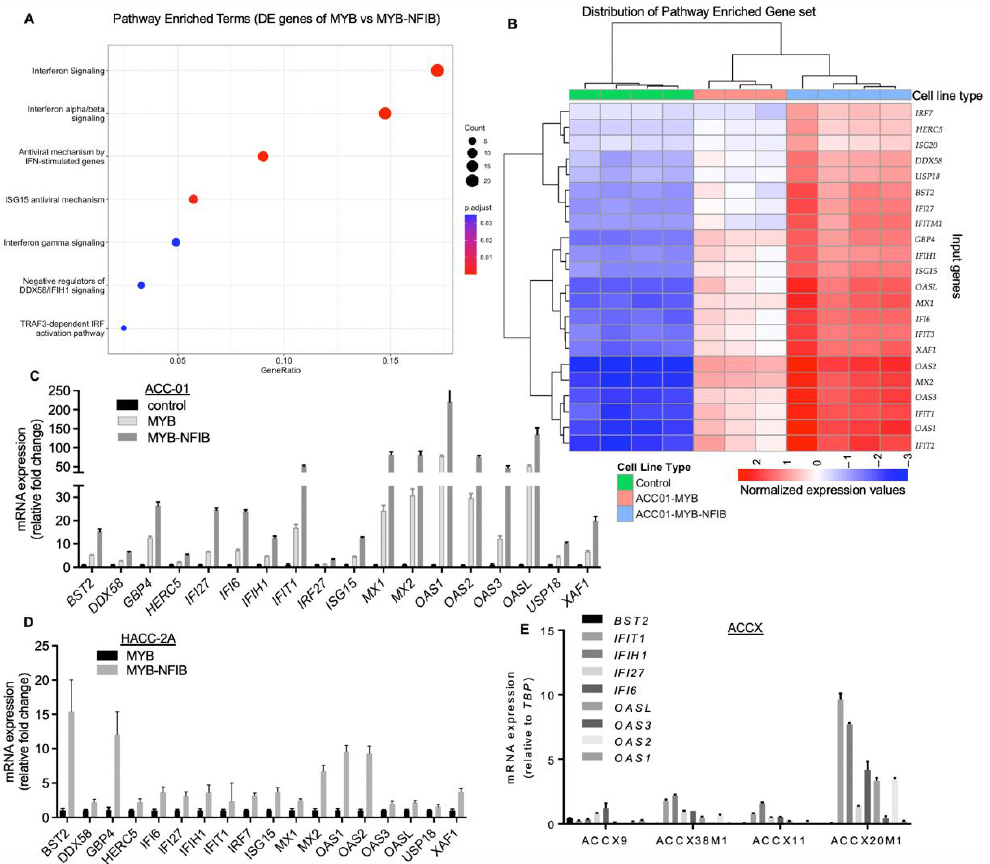
Figure 5. Correlation of MYB-NFIB fusion expression with gene enrichment associated in interferon (IFN) signaling pathway. (A), Reactome pathway enrichment analysis of 215 annotated genes (FDR < 0.05) found in the MYB wt versus MYB-NFIB fusion differential gene expression analysis. The x-axis indicates the proportion of genes from this set contained in each pathway’s gene set. Twenty-two IFN pathway-associated genes were found in all. (B), Heat-map representation of the normal- ized and centered gene expression data of the 22 IFN signaling pathway-associated genes. Samples and genes were ordered using the hierarchical clustering with complete linkage of their Euclidean distances. Note: one MYB wt sample was excluded from the overall analysis because its RNA se- quencing read counts were too low to be included in the HiSeq4000 input. (C), Validation of the upregulated genes by qPCR. RNA extracted from parental control, MYB wt or MYB-NFIB fusion cells incubated in dox-media for 24 h were analyzed for the expression of the various gene targets. (D), qPCR analysis of the target genes in HACC-2A cells expressing MYB wt or MYB-NFIB fusion. (E), RNA extracted from the indicated ACCXs were evaluated for the expression of representative gene targets as shown. We acquired all genes featured in the enriched pathways along with corresponding genes from the control set and performed a hierarchical clustering. This allowed us to compare the unique gene set expression profile across the controls, MYB wt and MYB-NFIB fusion groups. Notably, IFN signaling pathway-associated genes were distinctly upregu- lated in MYB-NFIB fusion compared to MYB wt samples, with the latter being higher rela- tive to the control group (Figure 5B). Genes identified in these specific pathways were IFN inducible factors such as, IFIT1, IFIT2, IFIT3, IFITM1, MX1, MX2, BST2, ISG15, ISG20, as well as members of the 2′ - 5′ -Oligoadenylate Synthetase, comprising of OAS1, OAS2, OAS3 and OASL [34,35] . Others include genes related to IFN pathways like, DDX58, USP18, GBP4, IRF7, and XAF1. Quantitative PCR analysis validated the elevated expres- sion of these gene sets in MYB-NFIB fusion cells relative to MYB wt or the control ACC-01 cells (Figure 5C). Similar analysis in HACC-2A cells confirmed that the IFN signaling